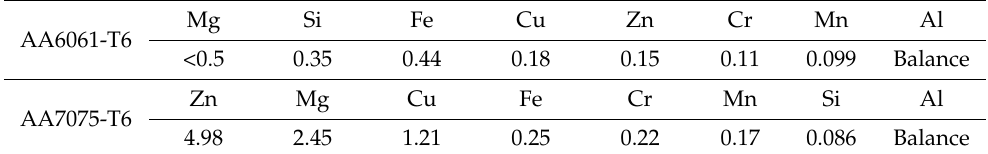
Table 1. Elemental composition of studied AA6061-T6 and AA7075-T6. AA6061-T6